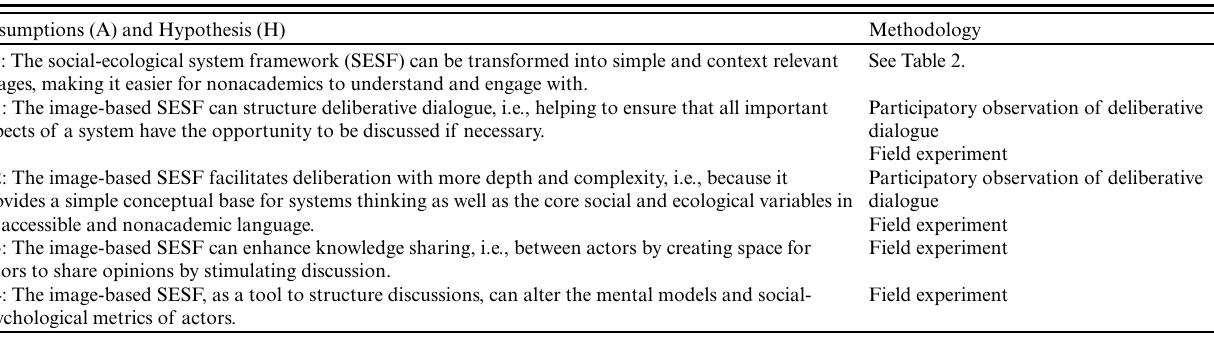
Table 1 . Assumptions, hypotheses, and methods used in this study.